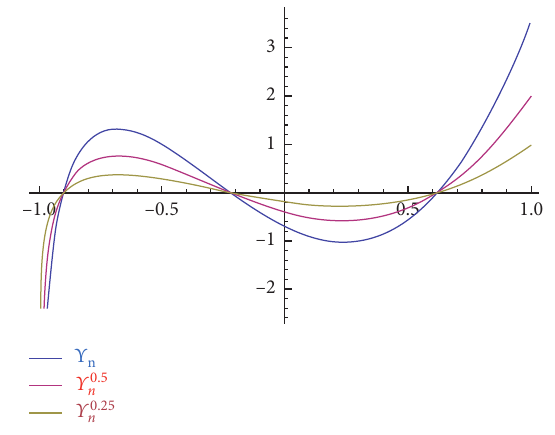
1: CCP for different values of ] and ( v, t ) � ( 1 − ] ) / Γ ( ] + 1 ) , κ ( ] ,t ) � ] / Γ ( ] + 1 ) . It pretenses to the κ 1 0 historical illustrations for Υ n ( t ) (see